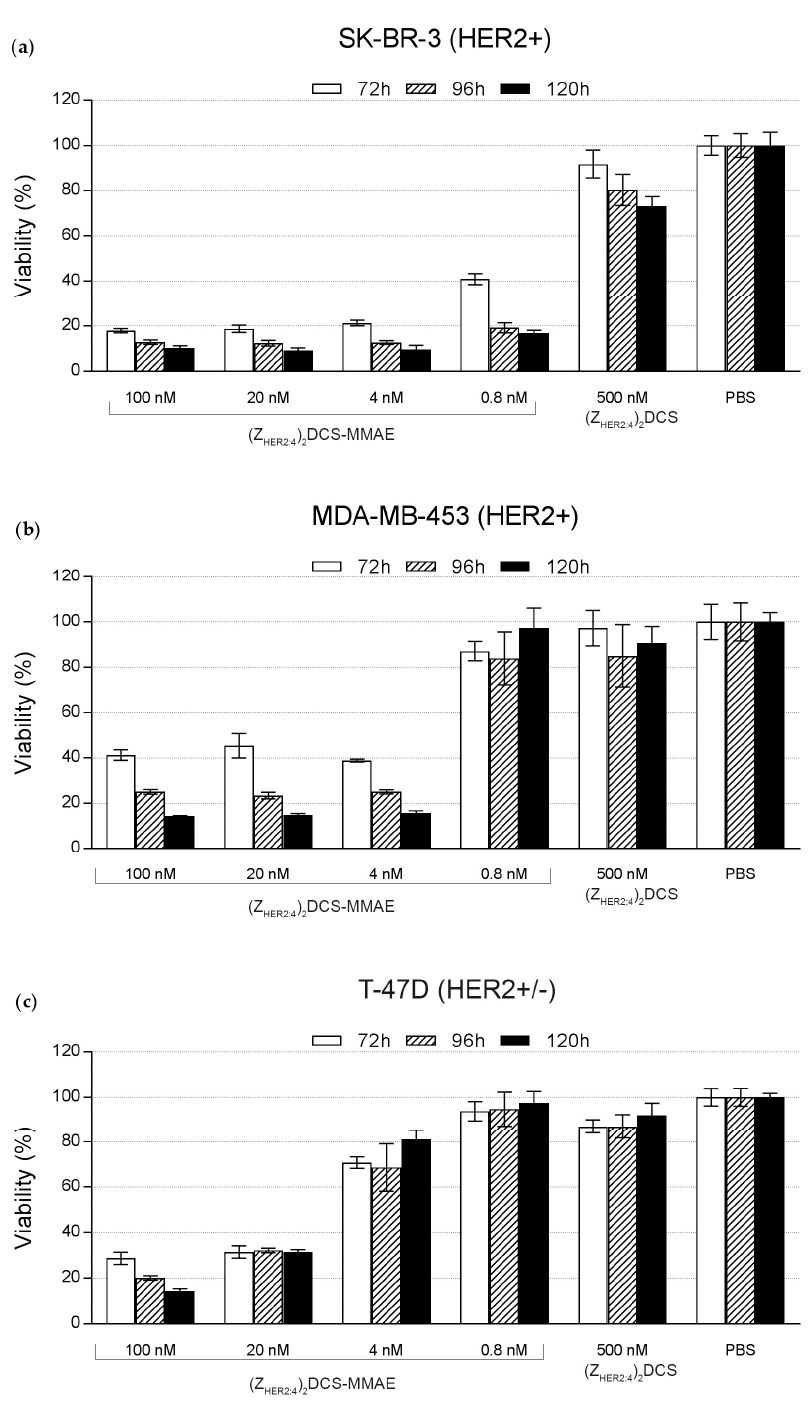
Figure 9. Viability assay results for human breast cancer cell lines ( a ) SK-BR-3 (HER2+); and ( b ) MDA-MB-453 (HER2+); and T-47D (HER2+/ − ) ( c ). These cells were incubated with the indicated doses of (Z HER2:4 ) 2 DCS-MMAE, 500 nM MMAE, and 500 nM (Z HER2:4 ) 2 DCS. Cell viability was assessed after 72, 96, and 120 h incubation. The error bars show the standard deviation.